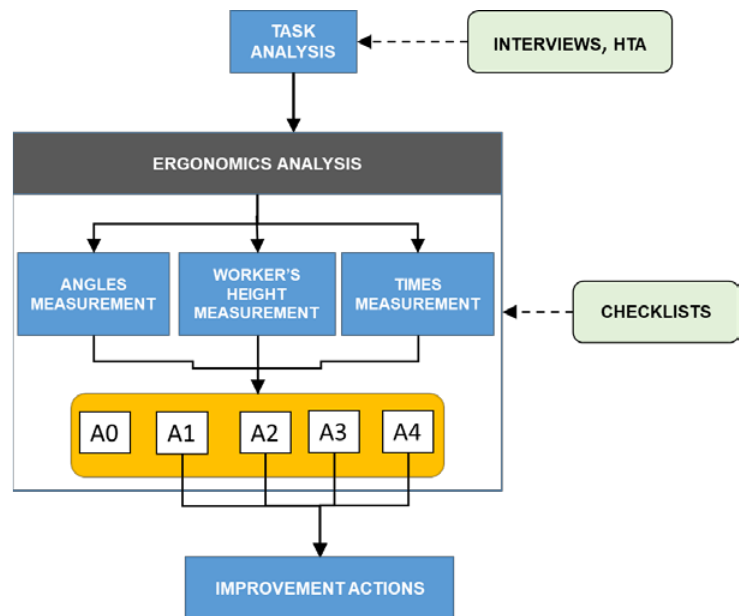
Figure 8. Scheme of the proposed procedure for ergonomic risk assessment of static working postures, where: A0 stands for “acceptable”; A1 means “not recommended—workstation redesign”; A2 stands for “not recommended—workflow redesign”; A3 means “not recommended—need for recovery time”; A4 means “not recommended—reduction of holding time”.